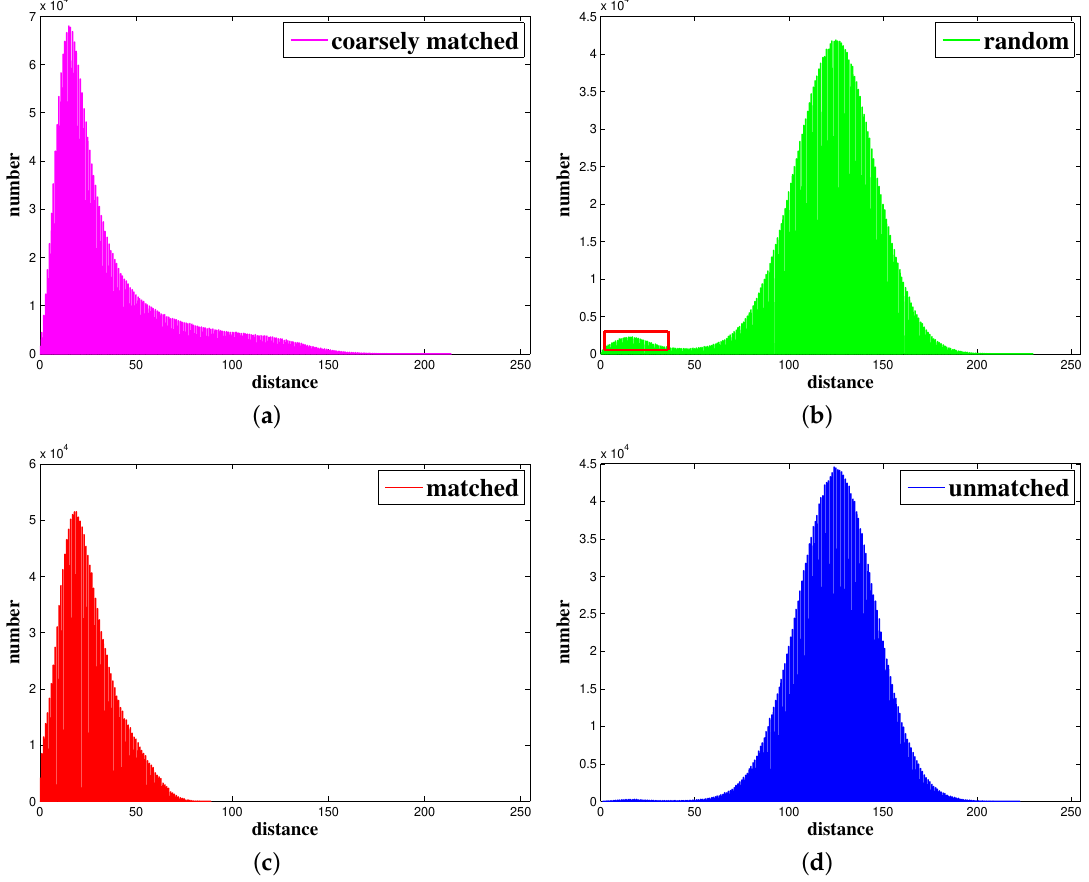
Figure 2. Statistical distribution of ORB descriptor [32] distances for coarsely matched, strictly matched, random constructed, and unmatched Shi-Tomasi feature pairs. The X axis represents descriptor distances and ranges from 0 to 255. The range of the Y axis is determined by the number of feature pairs in each experiment. ( a ) Coarsely matched features results. ( b ) Random constructed features results. ( c ) Strictly matched features results. ( d ) Unmatched features